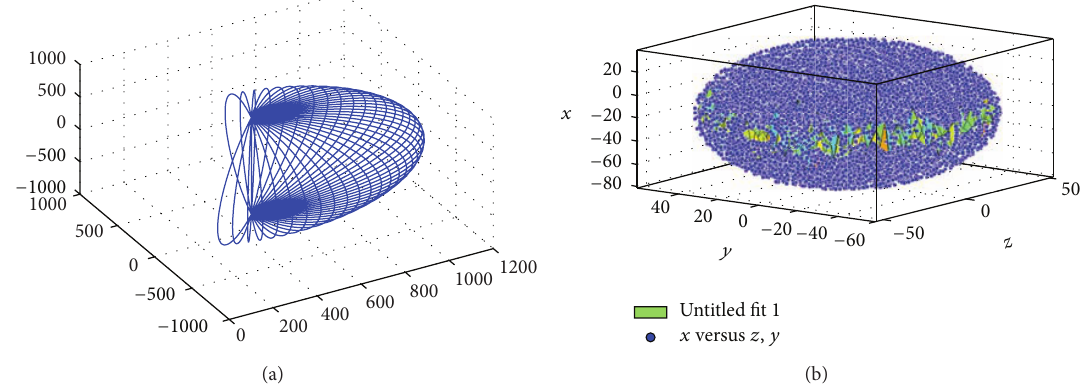
Figure 27: (a) Outer region covered by Exorn. (b) Workspace covered by Exorn.